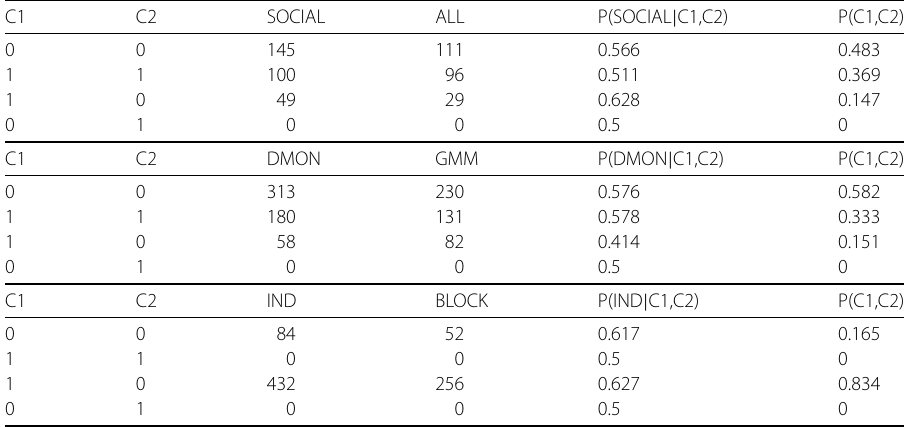
Table 7 Categorical compactness of the conclusions obtained in our study. C ∗ = 0 indicates a map whose compactness is below the median score (0.425), 1 indicates above the median C1 C2 SOCIAL ALL P(SOCIAL | C1,C2)